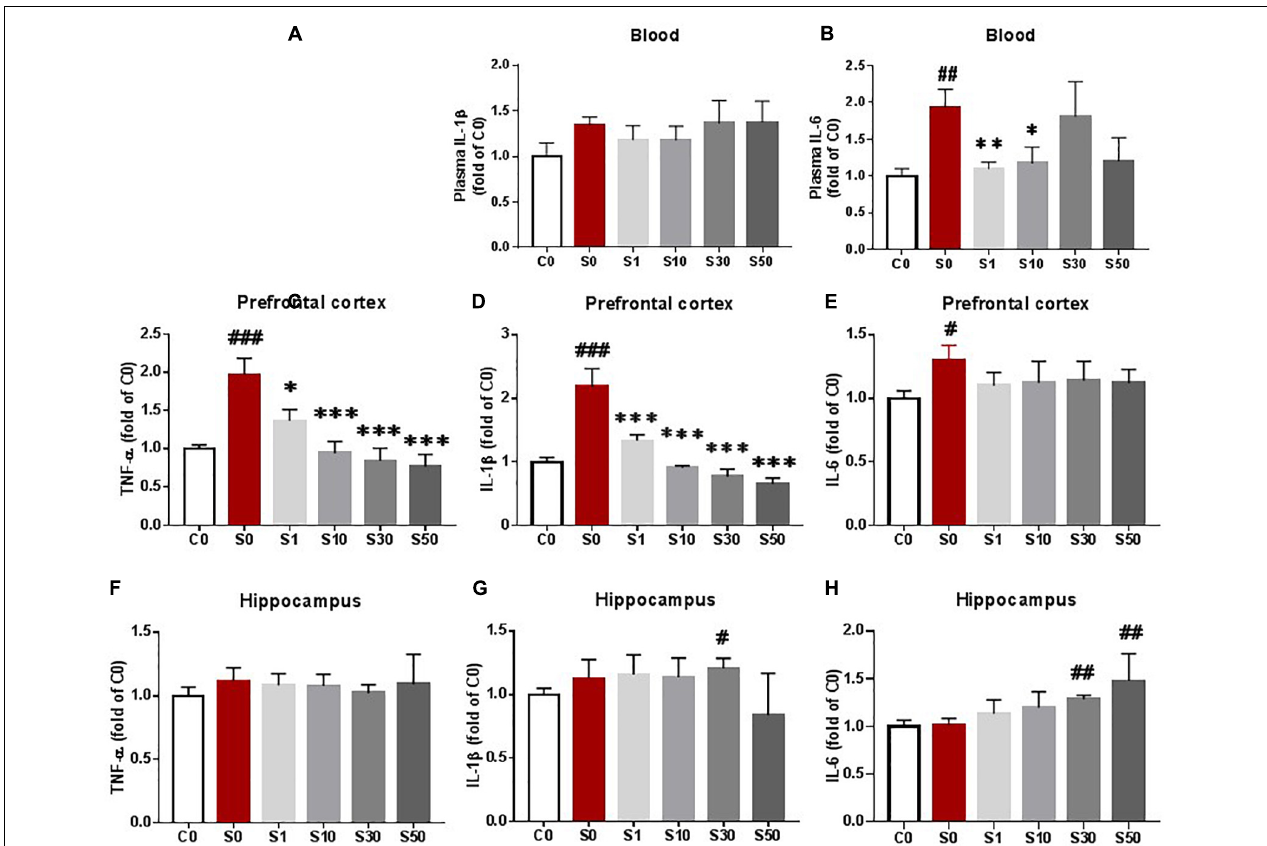
FIGURE 3 | Nobiletin (NOB) attenuated systemic cytokine levels and prefrontal cortical inflammation as assessed by enzyme-linked immunosorbent assay (ELISA). Vehicle or NOB at doses of 1, 10, 30, and 50 mg/kg body weight were intraperitoneally injected, respectively, once per day for 7 consecutive days before surgery. Mice underwent exploratory laparotomy under sevoflurane anesthesia the next day after NOB pretreatment. Blood (A,B) , prefrontal cortex (C,D,E) and hippocampus (F,G,H) were harvested 24h after surgery to test proinflammatroy cytokine by ELISA. C0: control group without surgery; S0: surgery group with vehicle pretreatment S1,S10,S30,S50: surgery group with NOB 1,10,30, 50mg/kg pretreatment. The value of the C0 group was set to 1. # P < 0.05, ## P < 0.01, ### P < 0.001. n = 6, compared with the C0 group. * P < 0.05, ** P < 0.01, *** P < 0.001, n = 6, compared with the S0 group. Results were presented as means ±